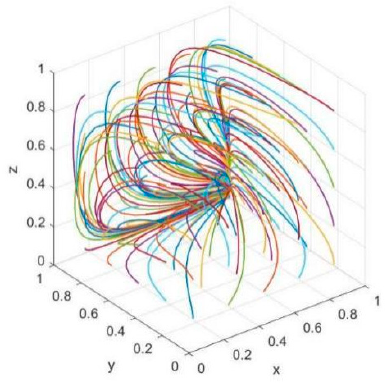
Figure 3. Evolutionary simulation at the initial stage point (1, 1, 0).